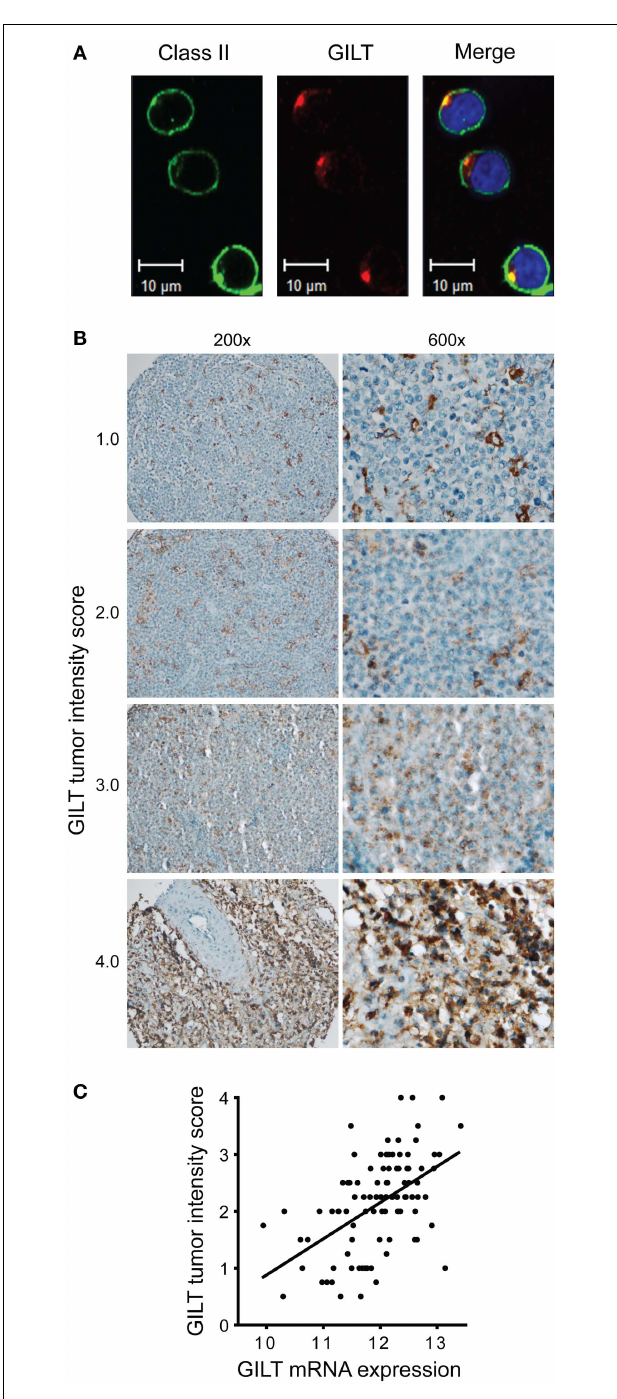
FIGURE 5 |Variation in GILT protein expression in DLBCL tumor cells correlates with mRNA expression . (A) In OCI-LY19, a DLBCL GCB subtype cell line, GILT and HLA-DR expression were detected with Alexa Fluor 555-conjugated and Alex Flour 488-conjugated secondary antibodies, respectively. Images were viewed using a Zeiss LSM 710 confocal microscope with a Plan-APOCHROMAT 63 × /1.4 objective lens and Immersol 518, and acquired with Zen LE software (Carl Zeiss Microimaging Inc.,Thornwood, NY, USA). (B) Low (original magnification, × 200) and